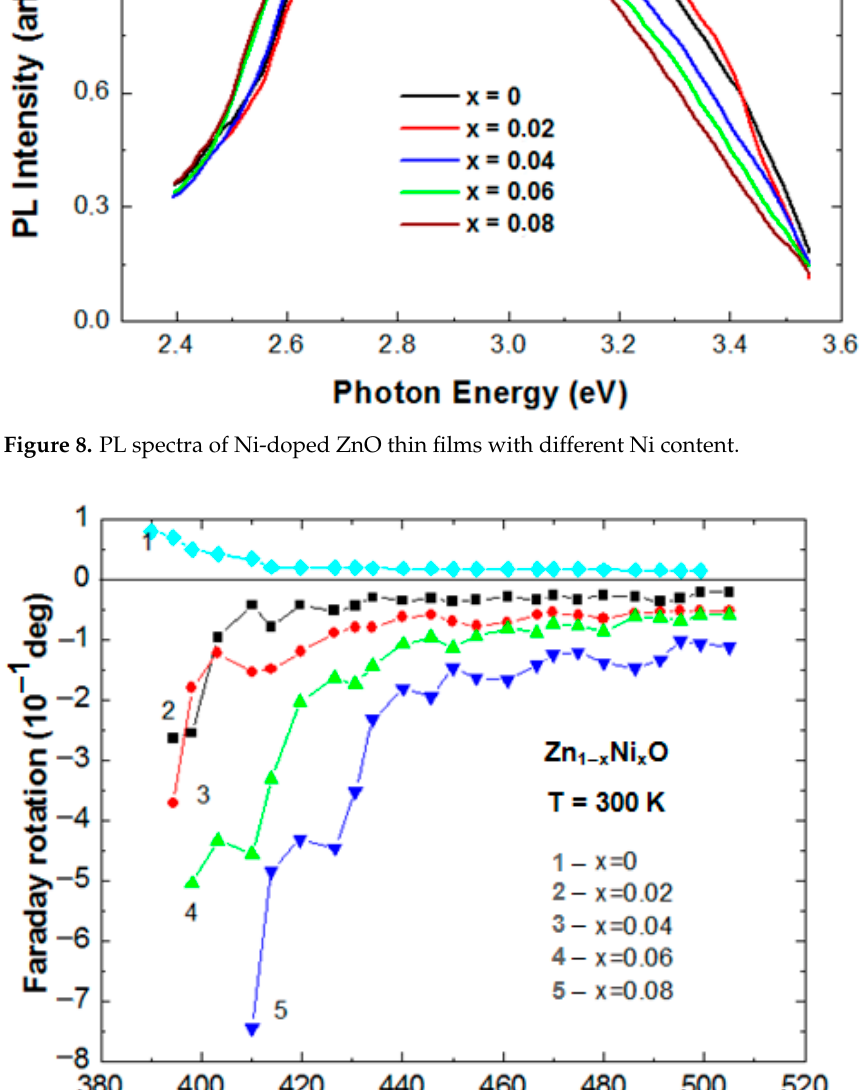
Figure 9. The Faraday rotation spectra as function of wavelength in Zn 1 − x Ni x O thin films on glass substrate.